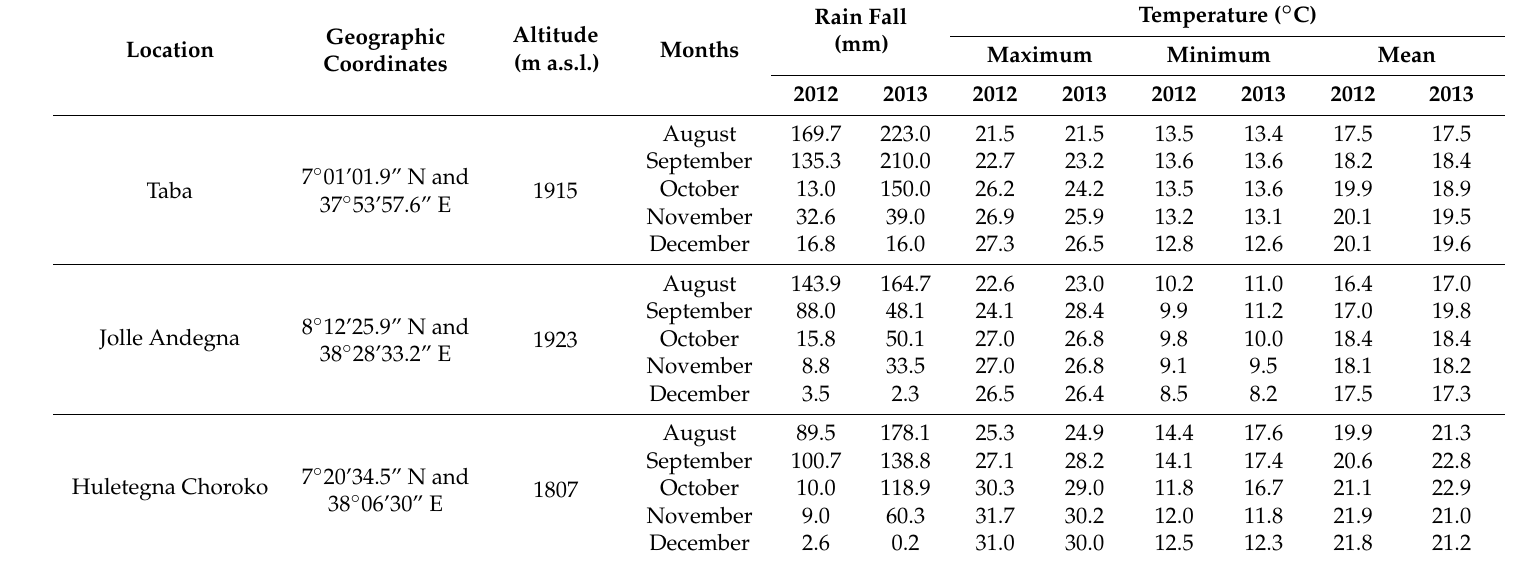
Table 9. Geographic coordinates, altitude (meters above sea level, m a.s.l.), monthly rainfall (mm), and temperature (maximum, minimum, and mean) data during the 2012 and 2013 growing seasons for each research